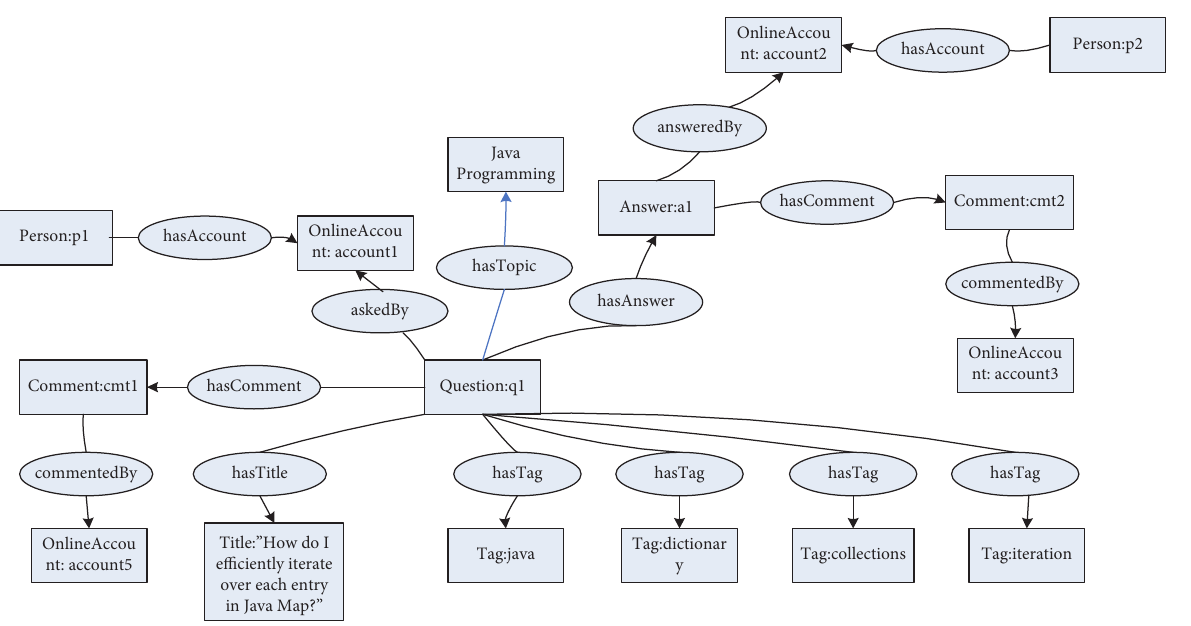
Figure 2: Example of social relationship graph representation for a question.